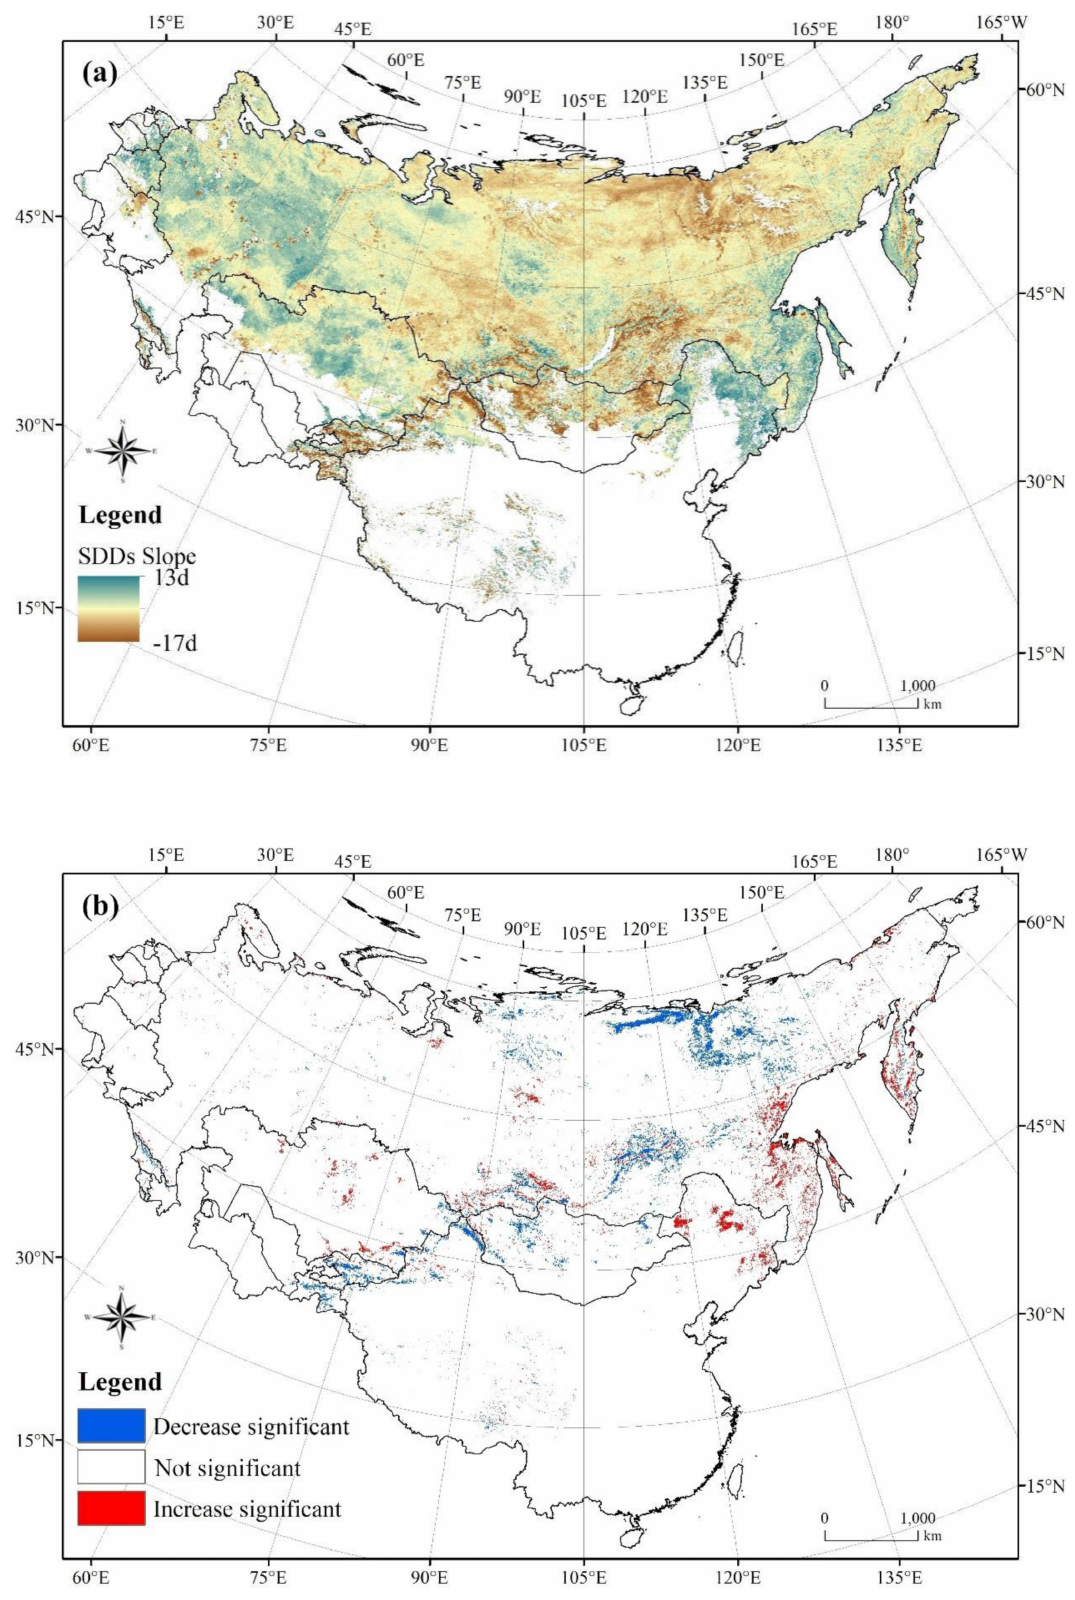
Figure 15. ( a ) The trend of SDDs, and ( b ) the significant test in the study area from 2000 to